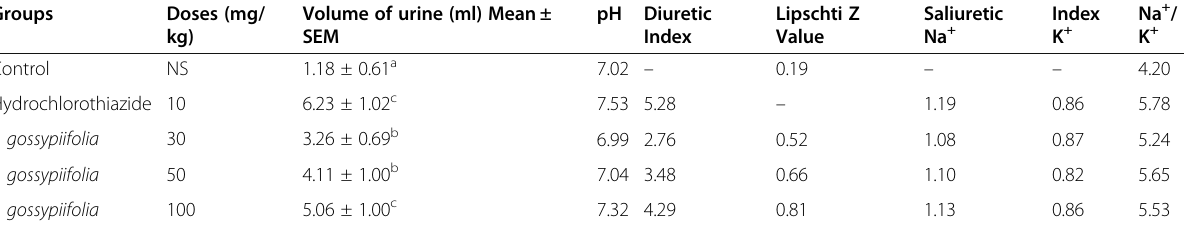
Table 2 Effect of J. gossypiifolia on urinary volume and electrolyte concentration Groups